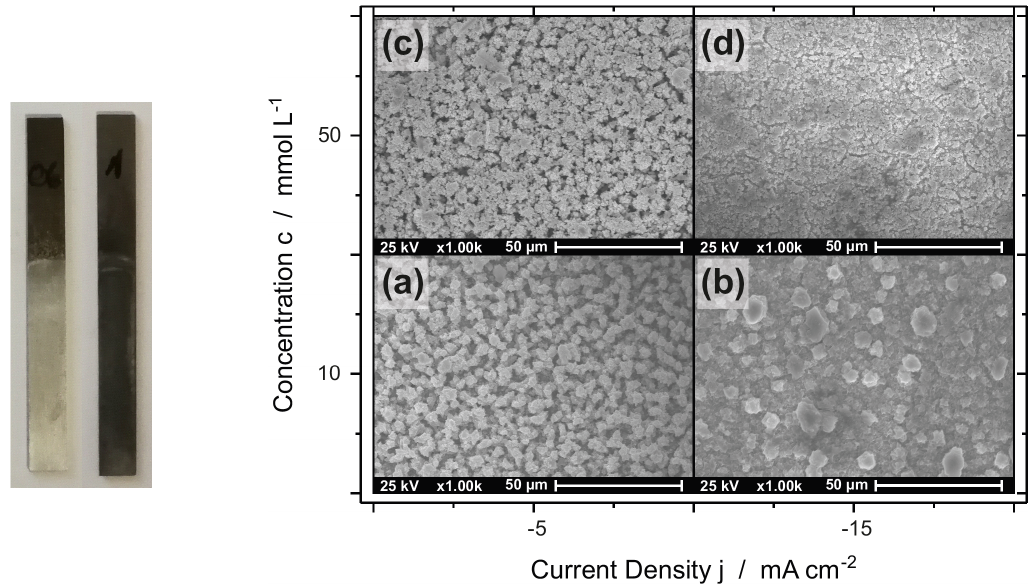
Figure 5. Photographs of AlSn coatings on steel with increasing Sn content (left to right: 0.3 wt% and 15.2 wt%) and SEM images of AlSn alloys on steel substrate, deposited at −5 mA cm −2 ( a , c ) and −15 mA cm −2 ( b , d ) from [EMIm]Al 2 Cl 7 –10Sn ( a , b ) and [EMIm]Al 2 Cl 7 –50Sn ( c , d ).